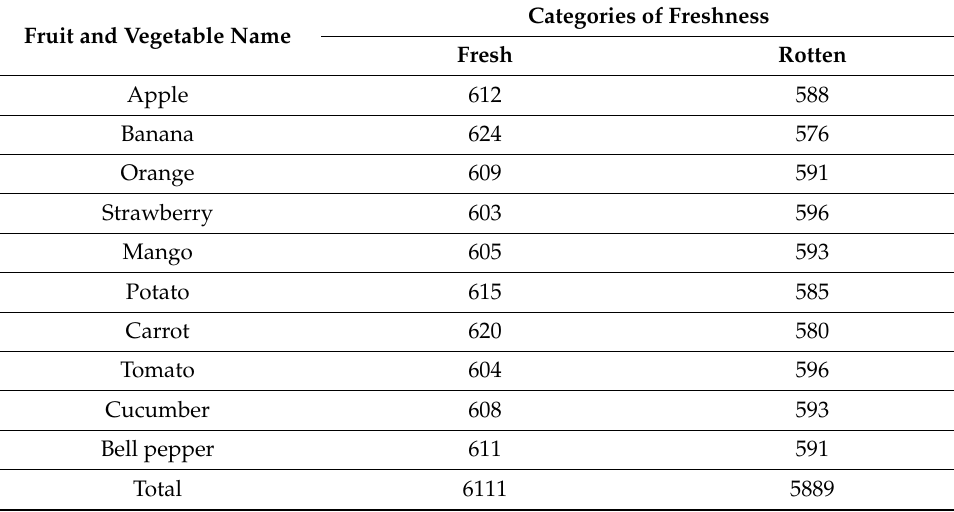
Table 1. The fruit and vegetable dataset consists of 12,000 images of 5 fruits and 5 vegetables categorized into 20 classes. Image size is 608 ×